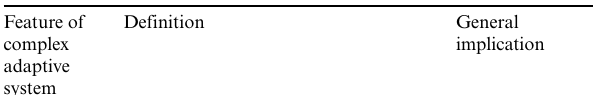
Table 3. Complexity framework. Six features of complex adaptive systems, their definitions and general implications. See guiding questions for how we assessed these features within the cases of resilience practice in Appendix 1. The table is adapted from Preiser et al.